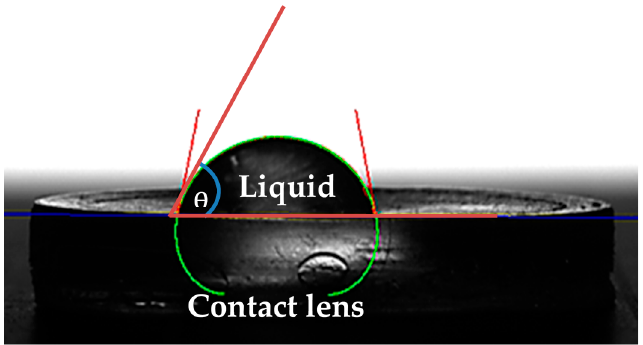
Figure 1. Measurement of contact angle is purely dependent on a series of connections recognized by Young (1805), where by the contact angle of a liquid drop on the solid surface is defined by the mechanical equilibrium of the liquid drop under the process of three tensions. This is defined as Young’s Equation (3).